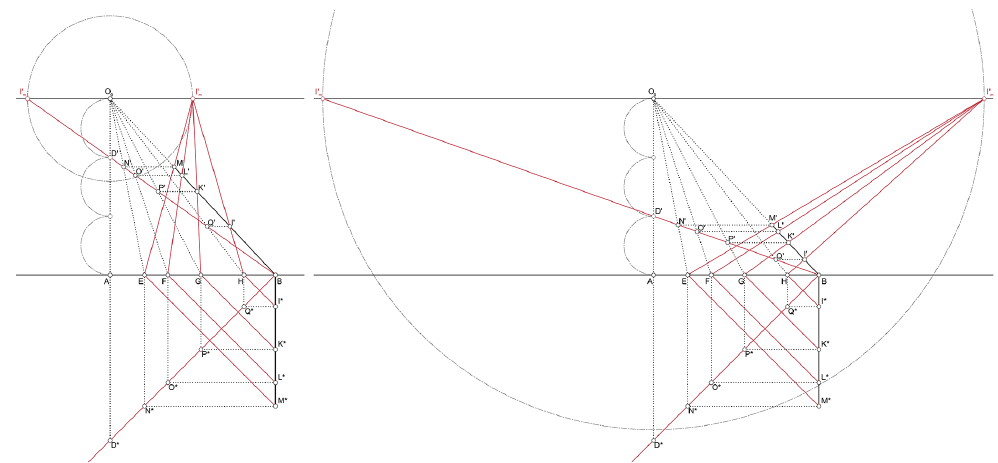
Figure 10 Comparison with the perspective